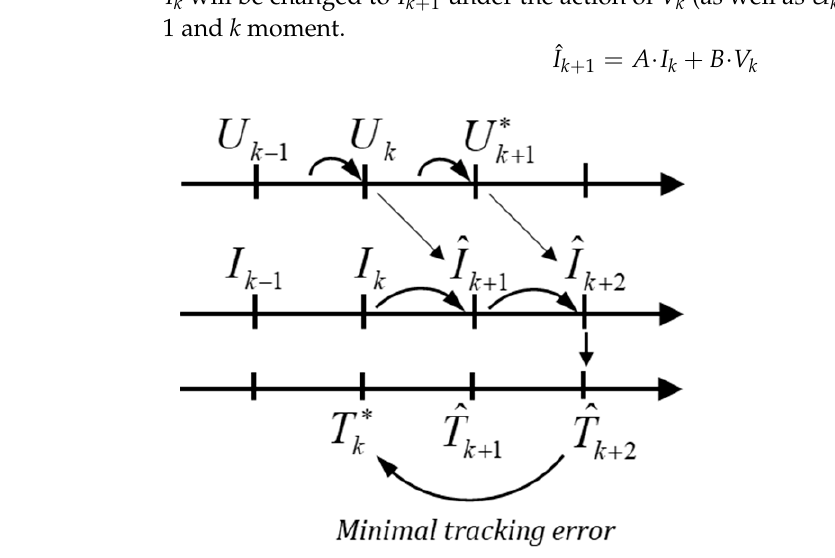
Figure 3. Time flow of the control process.